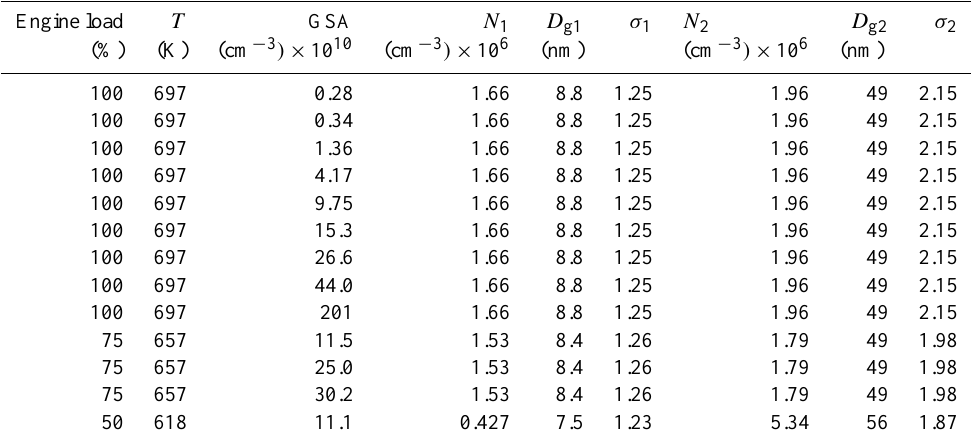
Table 1. Lognormal parameters (number concentration N , geometric mean diameter D g , standard deviation σ) for non-volatile exhaust particles and GSA concentration in raw exhaust at different engine loads and exhaust temperatures. Index 1 refers to the core mode and index 2 to the soot mode.